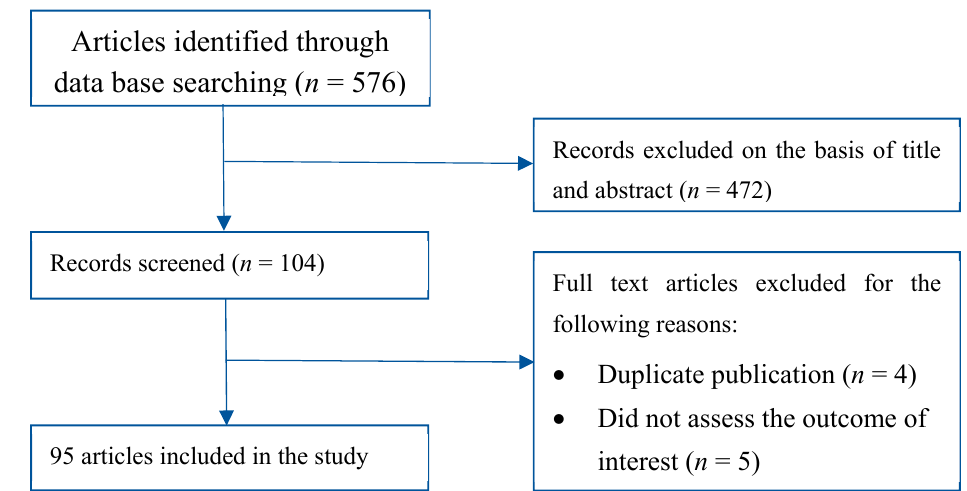
Figure 1. Literature search and review flow chart for selection of studies.